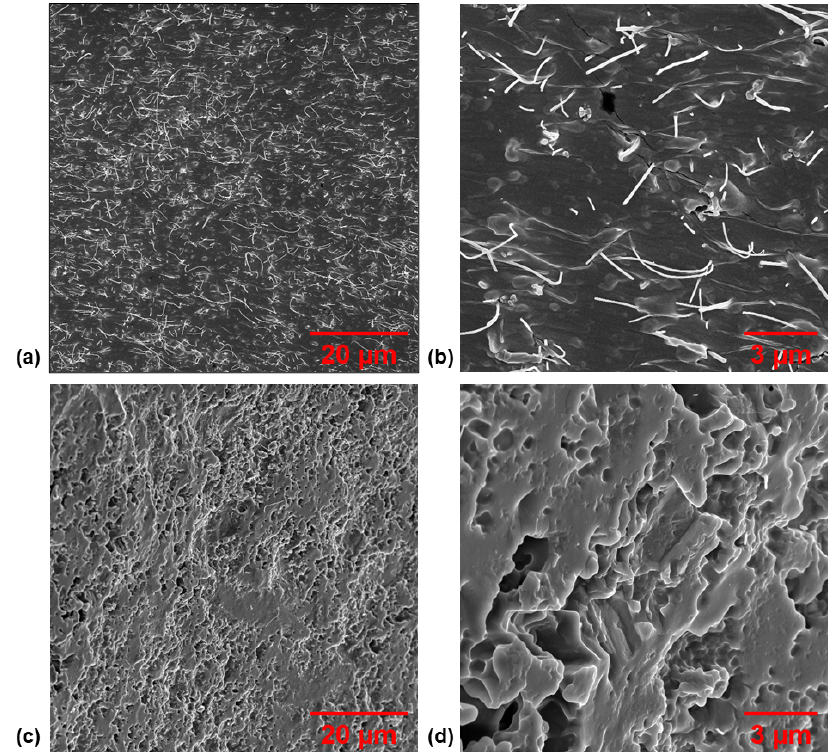
Figure 5. SEM images of the nanostructure of a nanocomposite sponge including ( a , b ) a cut sur- face of sponge exposing well-dispersed embedded CNTs and ( c , d ) an uncut surface of a sponge demonstrating successful embedding of the nanofiller within the polymer matrix.